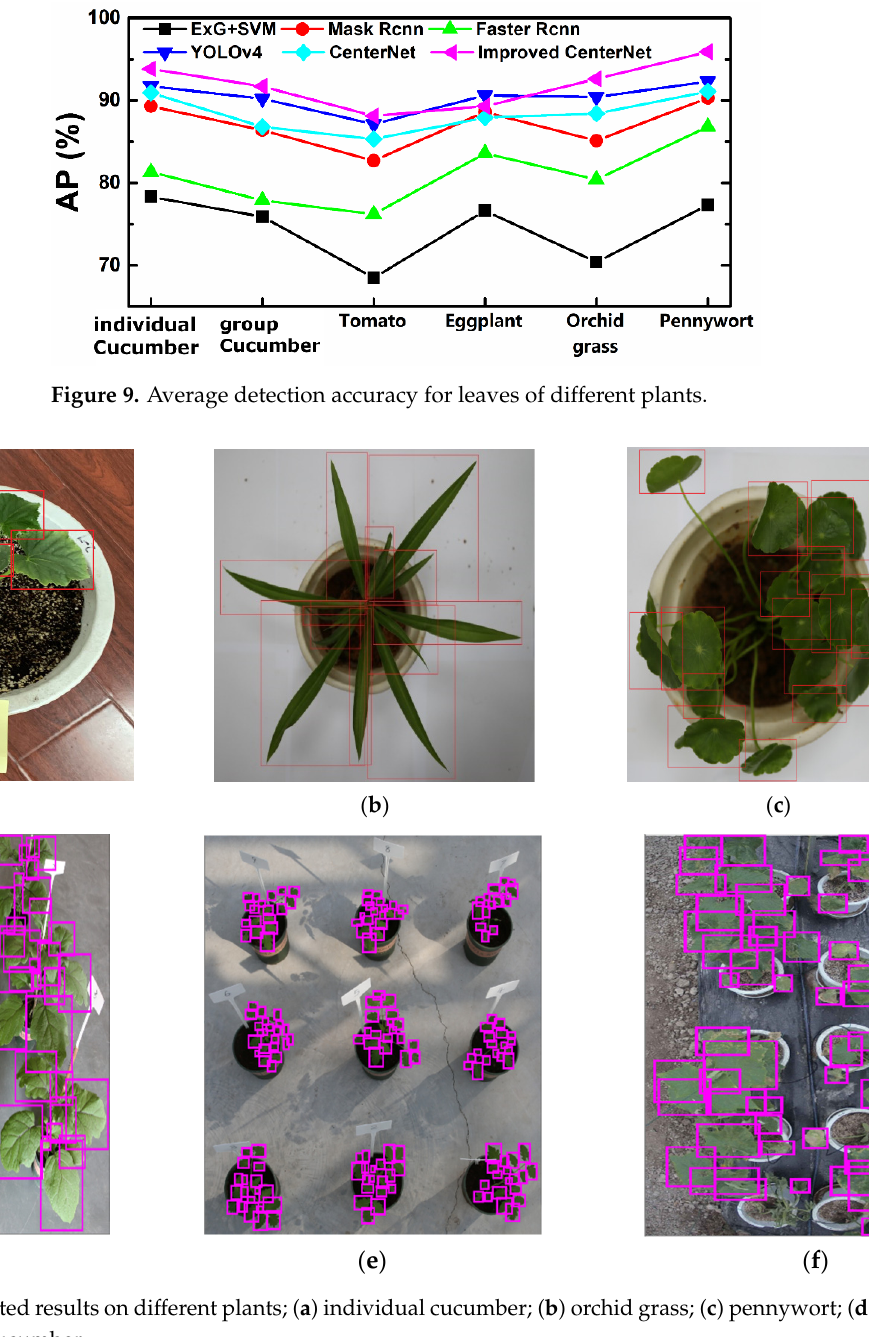
Figure 10. Visual detected results on different plants; ( a ) individual cucumber; ( b ) orchid grass; ( c ) pennywort; ( d ) eggplants; ( e ) tomato; ( f ) group cucumber.